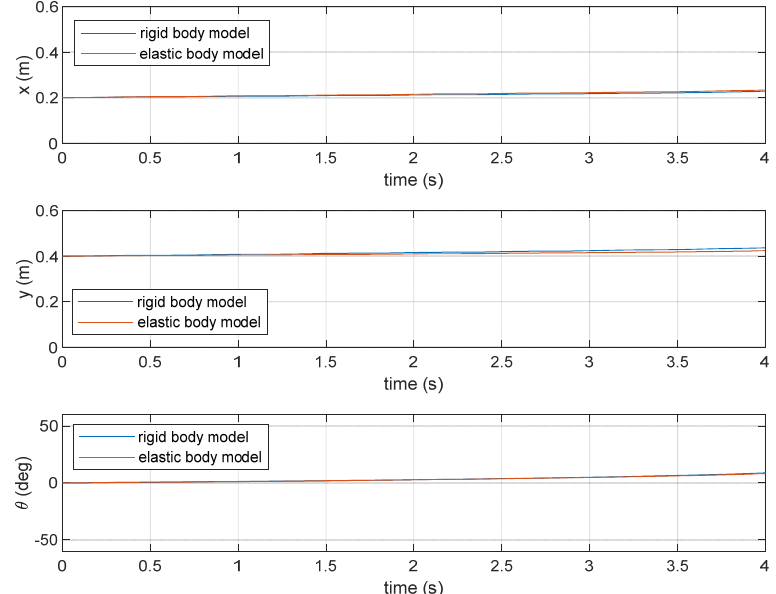
Figure 8. End-e ff ector position obtained by using rigid body and flexible body models based on Figure 8. End-effector position obtained by using rigid body and flexible body models based on Rayleigh-Ritz method in the case of sinusoidal loading. Rayleigh-Ritz method in the case of sinusoidal